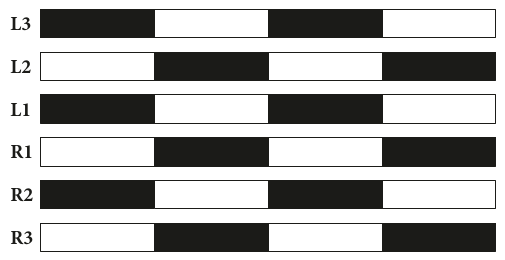
Figure 4: The foothold pattern diagram of regular tripod gait.